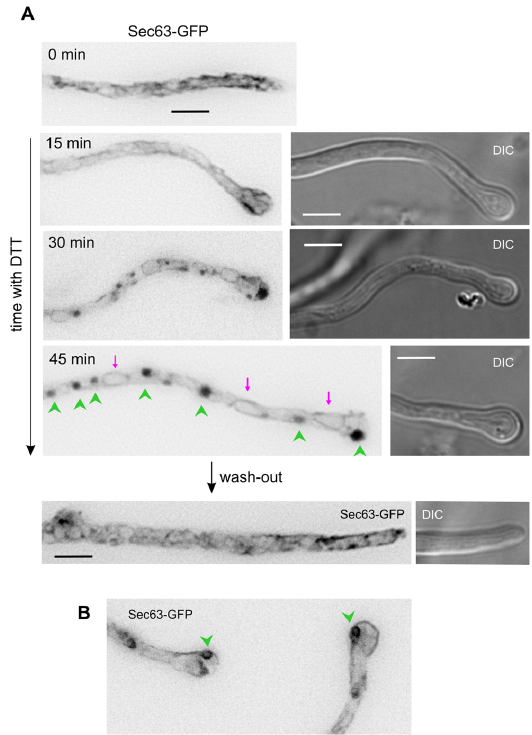
Figure 6. Reductive stress leads to aggregation of peripheral ER strands. A. Sec63-GFP images (inverted greyscale) of cells treated with DTT for the indicated time periods. Images correspond to maximal intensity projections of z-stacks processed with an ‘unsharp’ filter. In the 45 min GFP image, green arrowheads indicate aggregates of ER strands and magenta arrows indicate nuclei, whose NEs, unlike peripheral ER strands, appear unaltered. All images are shown at the same magnification. Bars, 5 m m. B. Examples of ring-shaped ER aggregates